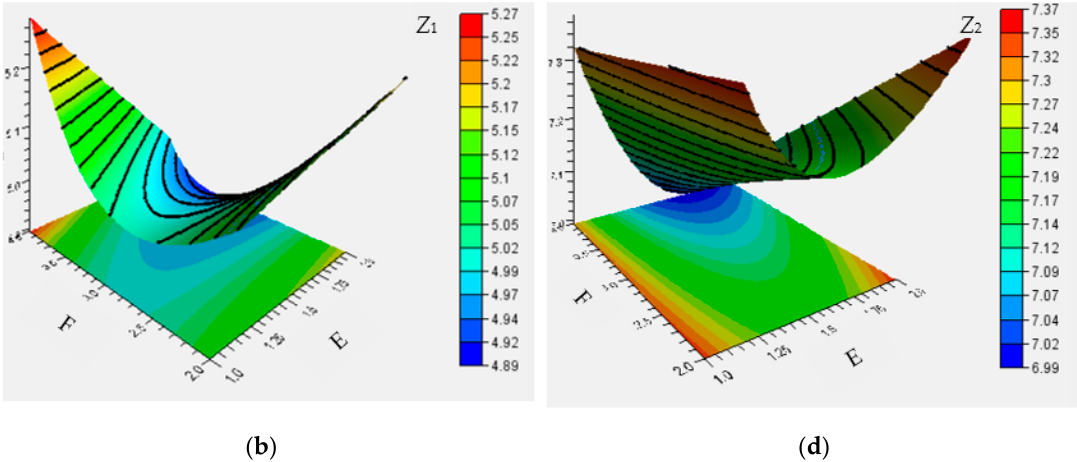
Figure 8. Interactive e ff ect of process parameters on thickness in the rapid cooling zone, ( a ) A and B on Z 1 , ( b ) A and B on Z 2 , ( c ) E and F on Z 1 , ( d ) E and F on Z 2